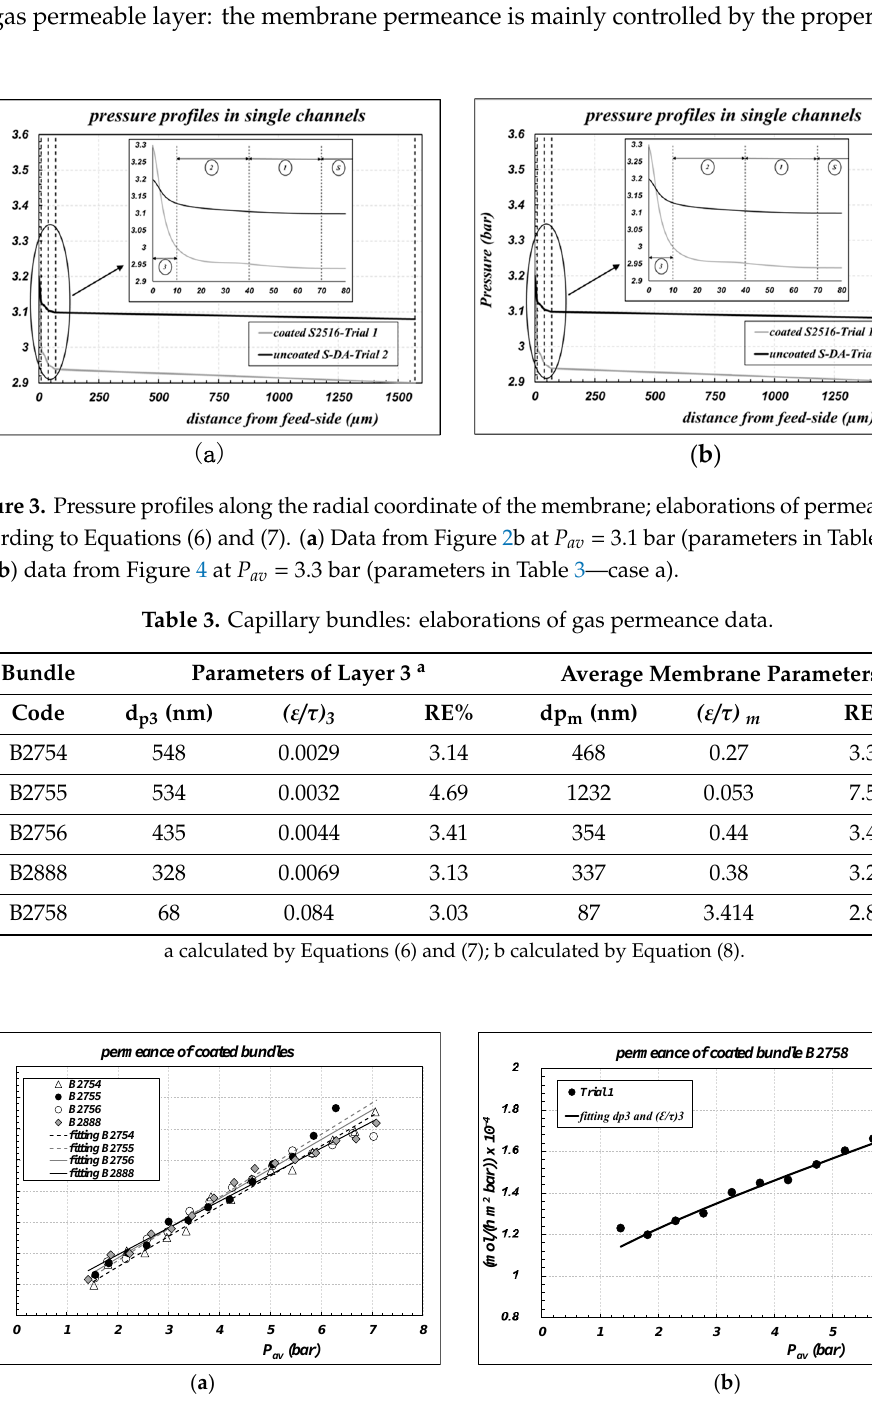
Figure 4. Air permeance of bundles at 24 °C, along the average pressure across the membrane. ( ∆ P tot = 0.09–0.54 bar). symbols = experimental data; lines = fitting by Equations (6) and (7). Parameters are collected in Table 3. Capillary bundles: elaborations of gas permeance data.